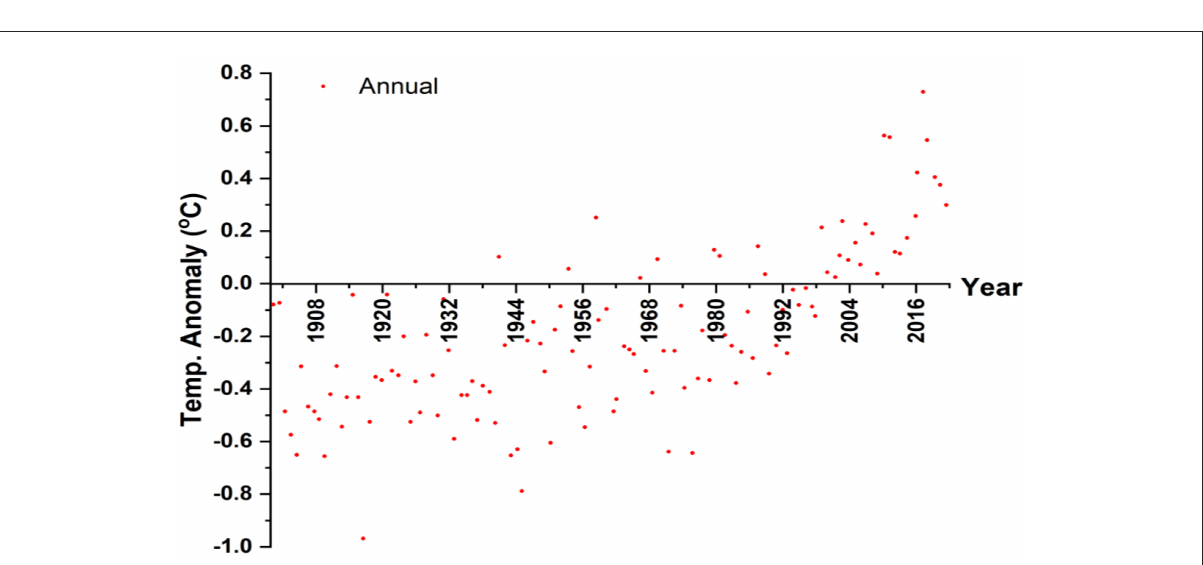
FIGURE2 Annual average air temperature anomalies on land surface from 1901 to 2020 with a base period of 1981 to